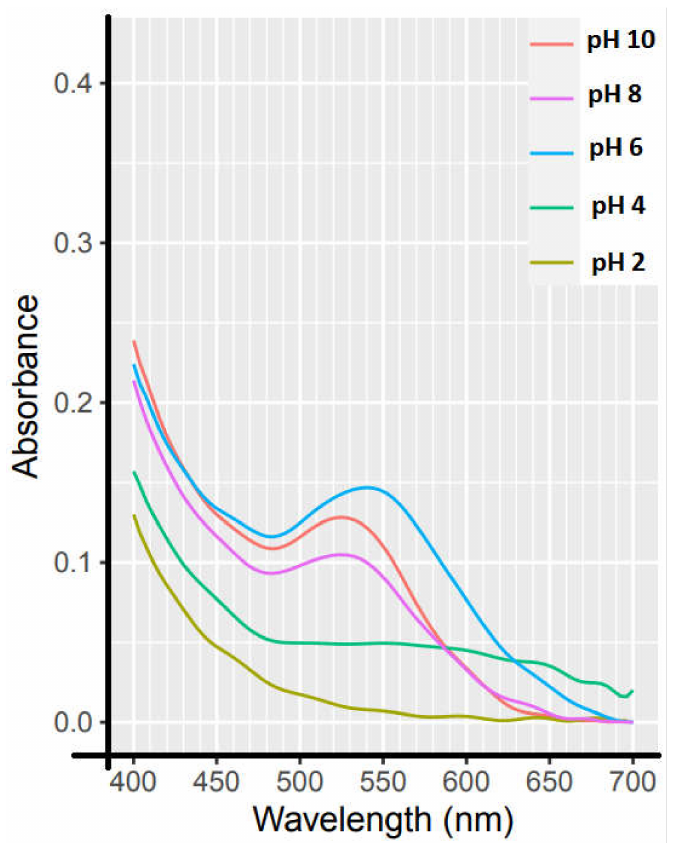
Figure 9. Visible spectra of five samples with different pH values (here the pH values were adjusted after the preparation of AuNPs with an initial pH of 10). The samples were diluted 1:2 with ddH 2 O. The statistical analysis of the measured AuNP diameters (Figure 11) for the sample with the pH adjusted to 6 after AuNP preparation is shown in Table 2. The mean diameter of AuNPs for this sample was 20 ± 7 nm. The value of the mean diameter of the AuNPs that had an initial pH before production that was six was different from that of the above sample. These data demonstrate the differences between nanoparticles that had a pH that was adjusted before or after their preparation. A comparison of these two samples based on their mean diameter values (boxplots and t -test) is shown in Figure 12. The ratio shows that the particles were not perfect spheres but had a similar shape to each other. Table 2. Summary of descriptive statistics of the size of a washed sample at pH 6 (the pH was adjusted after the preparation of the AuNPs) shown in Figure 10A,B. Abbreviations are shown in Table 1.